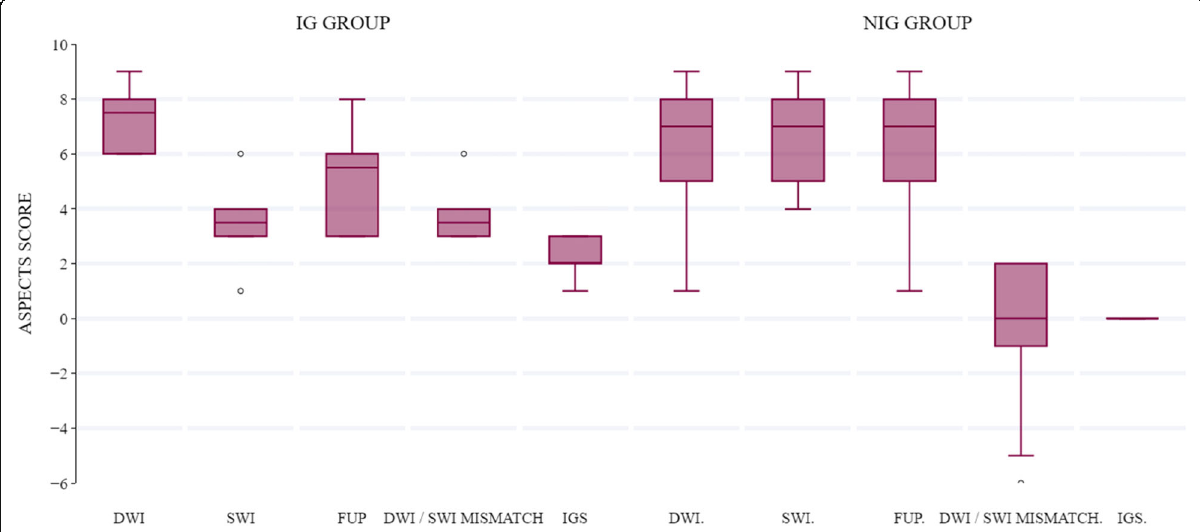
Fig. 3 Box plots of DWI, SWI, and FUP ASPECTS values as well as DWI/SWI mismatch and IG scores in both patient groups. Middle lines represent median values, boxes represent 25th to 75th percentiles, and whiskers demonstrate range. DWI diffusion-weighted imaging, SWI susceptibility-